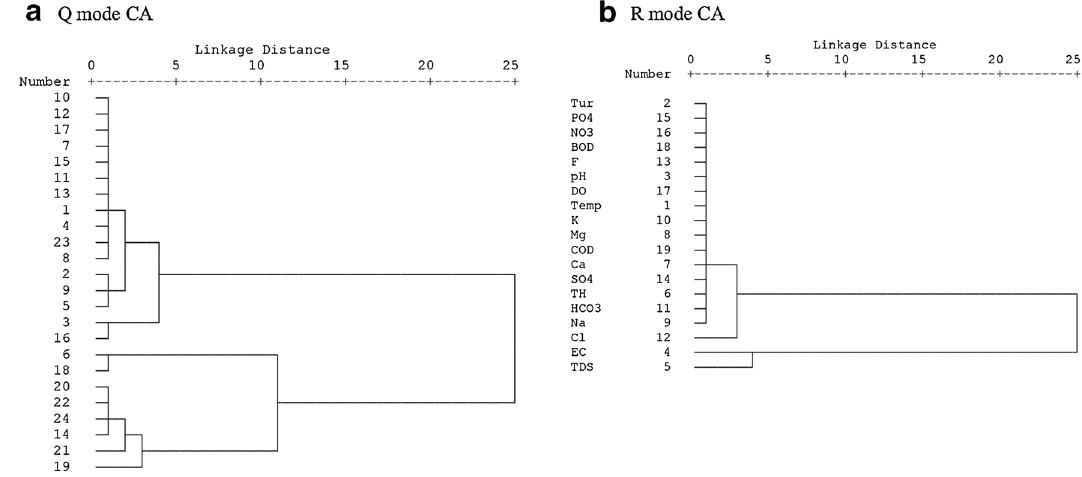
Fig. 11 a , b Dendrogram of the Q and R-mode hierarchical cluster analysis (August